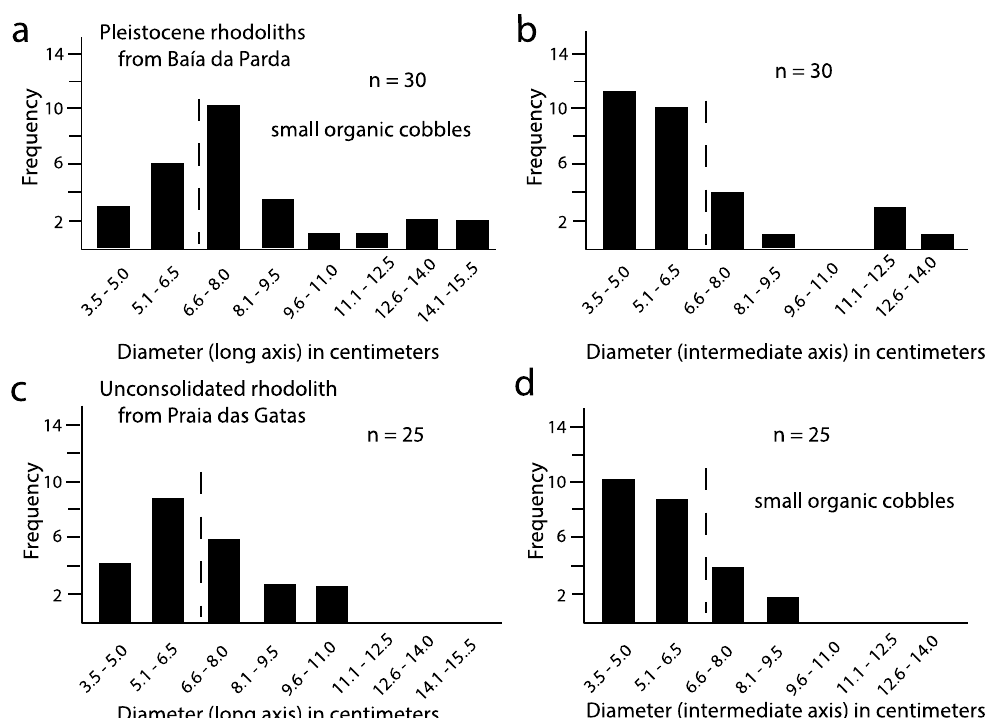
Figure 8. A set of bar graphs used to contrast size variations based on measurements of maximum and intermediate axes in rhodoliths sampled from Pleistocene and Holocene deposits; ( a ) Bar graph plotting the diameter from the long axis of Pleistocene rhodoliths; ( b ) Bar graph for the same rhodoliths but based on the length of intermediate axes; ( c ) Bar graph plotting the diameter from the long axis of rhodoliths in the Holocene deposit; ( d ) Bar graph for the same rhodoliths but based on the length of intermediate axes. Dashed vertical line denotes the size boundary between large organic pebbles and small cobbles.